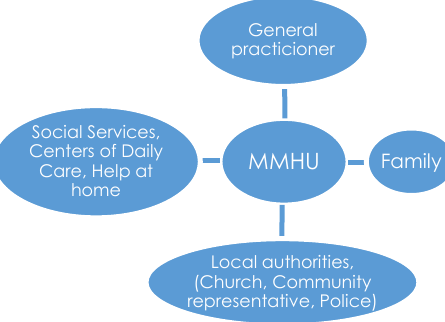
Figure 2. Network within the community.